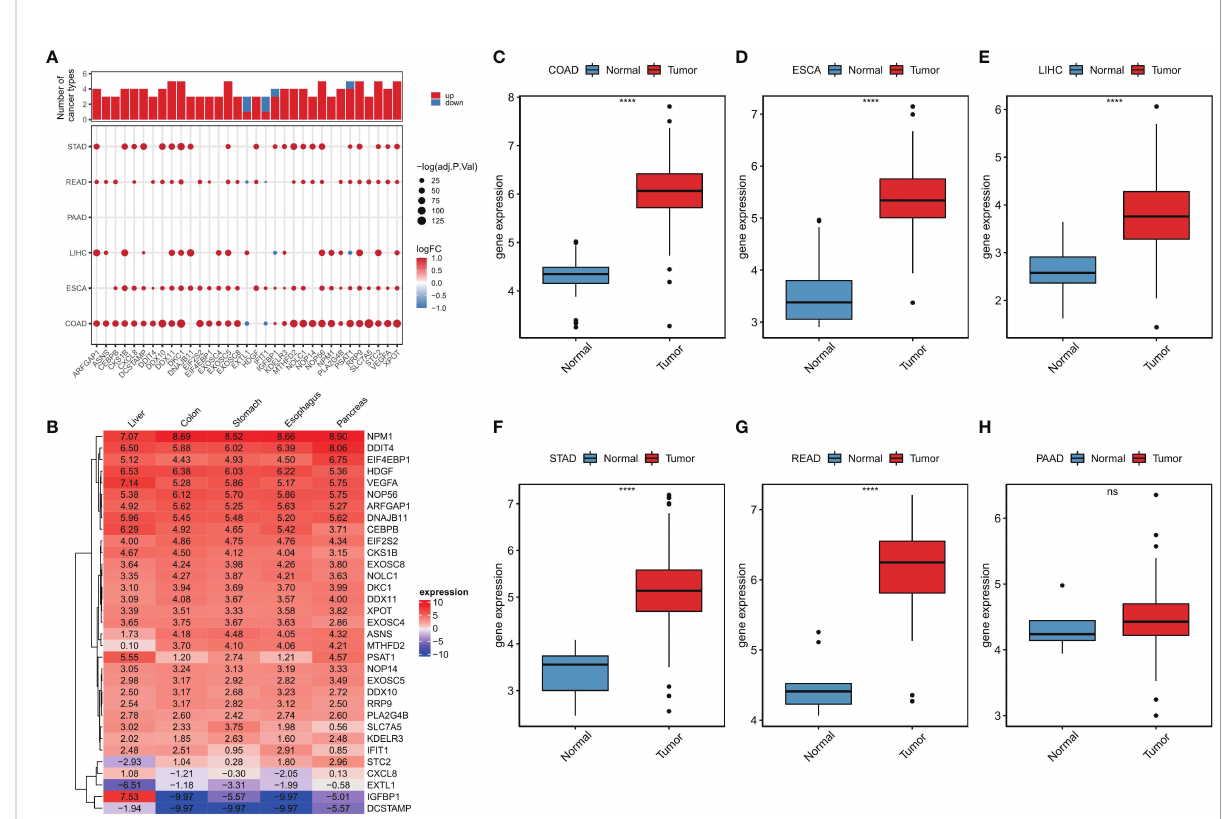
FIGURE 1 Abnormal expression of endoplasmic reticulum stress factor in digestive tract tumors. (A) Endoplasmic reticulum stress factors that show differential performance in at least three cancers; (B) The expression of ER stress factors in normal tissues that show differential expression in at least three cancers; Expression of (C-H) DKC1 gene in different digestive tract tumors. ****P<0.0001; ns, not signi fi